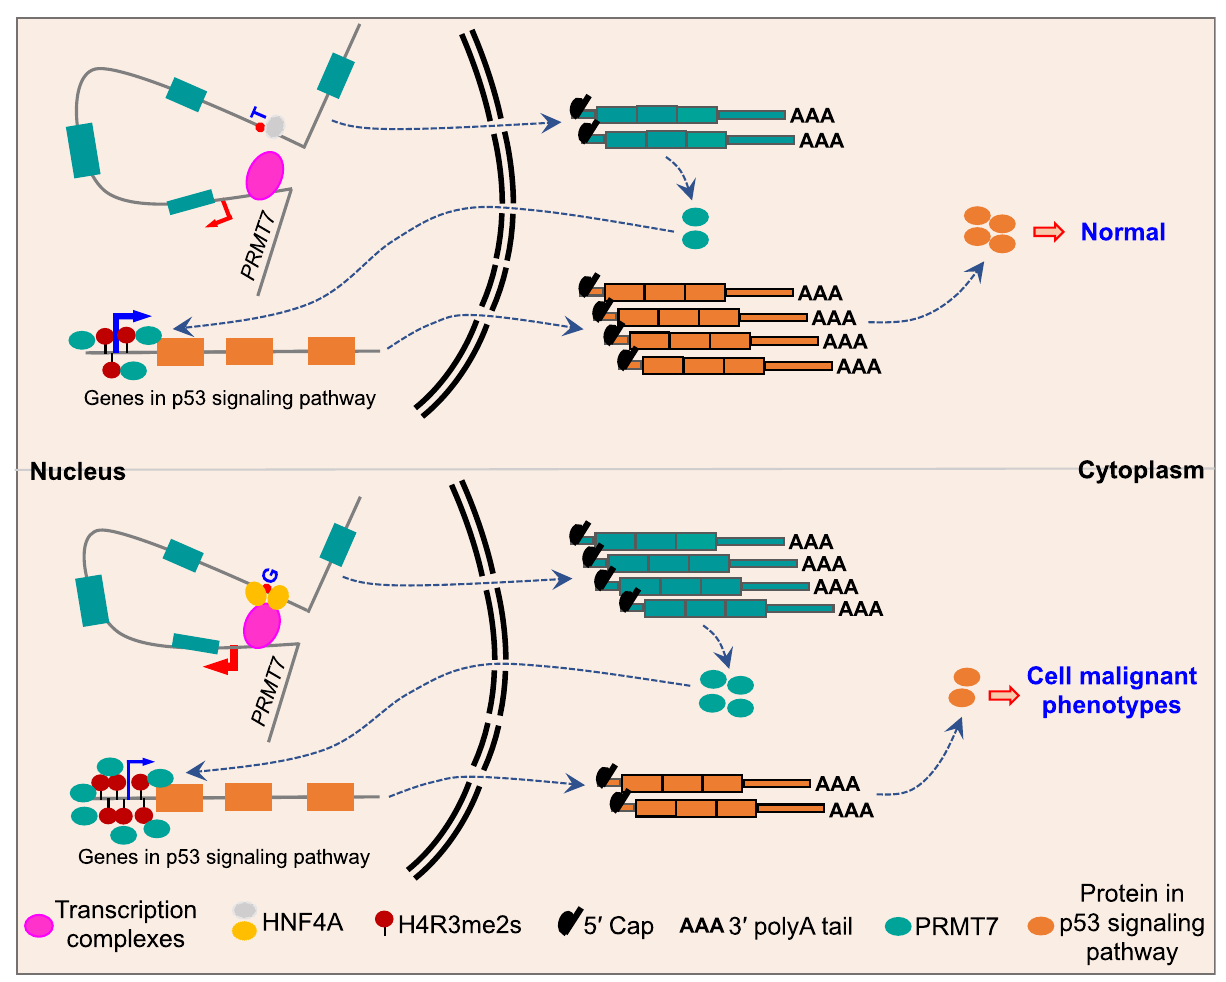
Fig. 7 Model for the functional mechanism of the HCC risk-associated enhancer variant rs73613962 in the intronic region of PRMT7 . The region containing the HCC susceptibility locus rs73613962 inside the intronic region of PRMT7 is identi fi ed as an enhancer that can regulate PRMT7 expression through the interaction with its promoter. Transcription factor HNF4A prefers to bind to the risk allele G over the non-risk allele T, which leads to the upregulated expression of PRMT7 . Under this condition, the H4R3me2s modi fi cation on the promoter region of the genes in the p53 signaling pathway is elevated; thereby, the RNA and protein level is reduced. As a result, cells are induced to have enhanced malignant phenotypes, with higher proliferation rate and migration and invasion